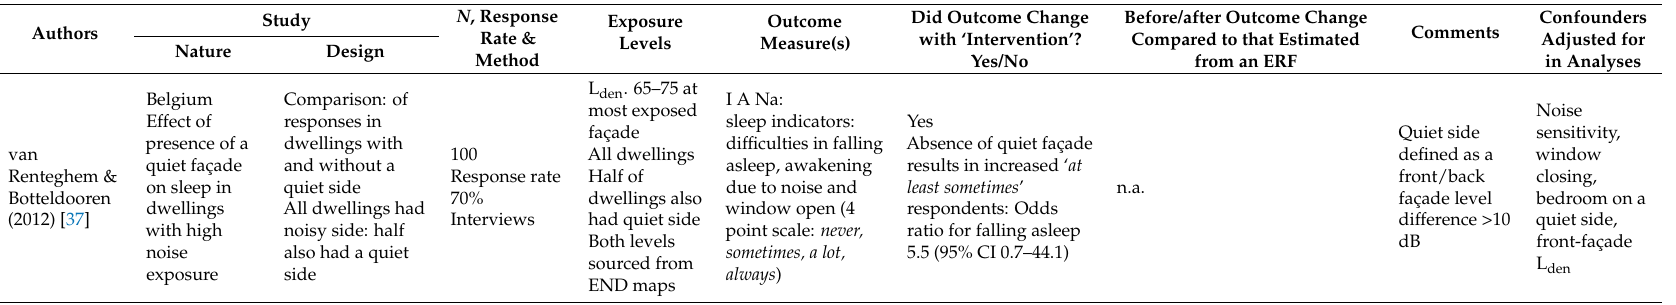
Table 10. Other Physical Intervention (Type